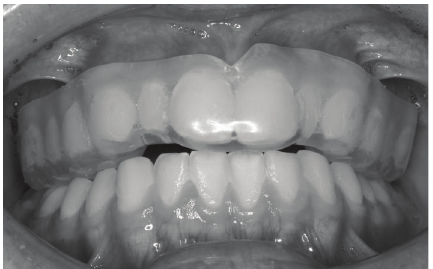
Figure 3: A night guard may be one of the possible solutions to prevent overloading of the suprastructure of implant prostheses. Soft material also could be used for night